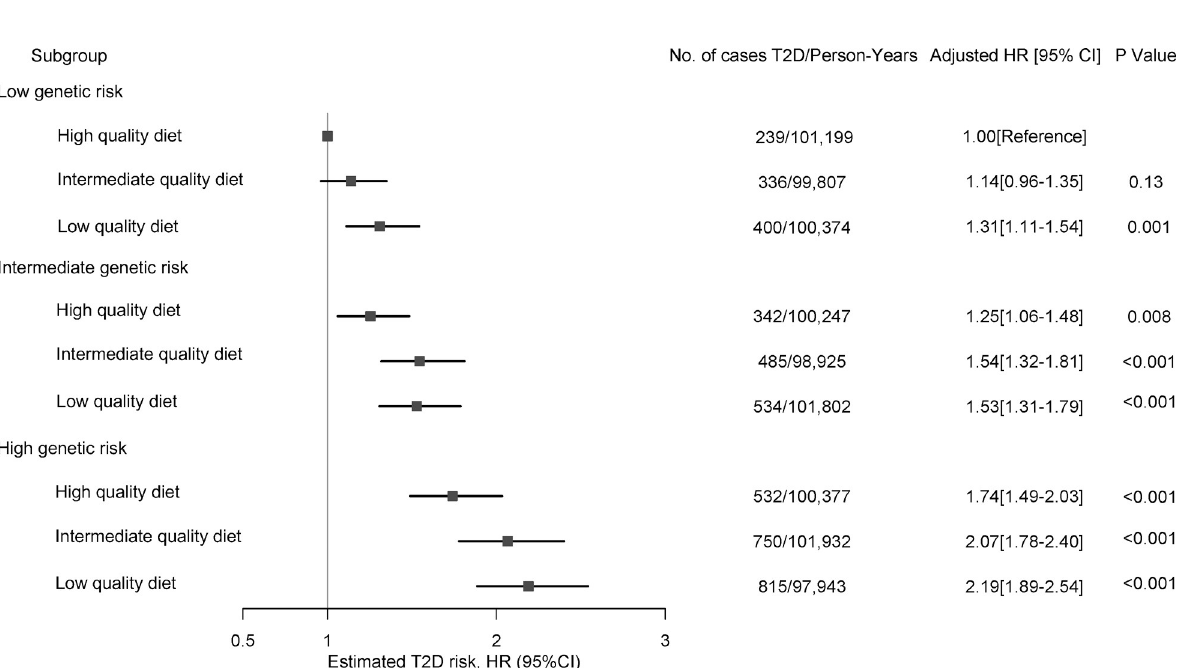
Fig 2. Risk of incident type 2 diabetes according to categories of genetic risk and diet quality. Shown are adjusted HRs and 95% CI of the estimate for type 2 diabetes in a pooled analysis of the 3 prospective cohorts according to categories of genetic risk and diet quality score. In these comparisons, participants with low genetic risk and high diet quality served as the reference group. Cox proportional hazards models were stratified by age and adjusted for ancestry-derived principal components, family history of diabetes, history of hypertension, history of hypercholesterolemia, menopausal status (women only), BMI, smoking status, physical activity, and total energy intake. Fixed-effects inverse variance weighted meta- analysis was used to combine cohort-specific results. B AU : AnabbreviationlisthasbeencompiledforthoseusedthroughoutFig 2 : Pleaseverifythatallentriesarecorrect : MI, body mass index; CI, confidence interval; HR, hazard